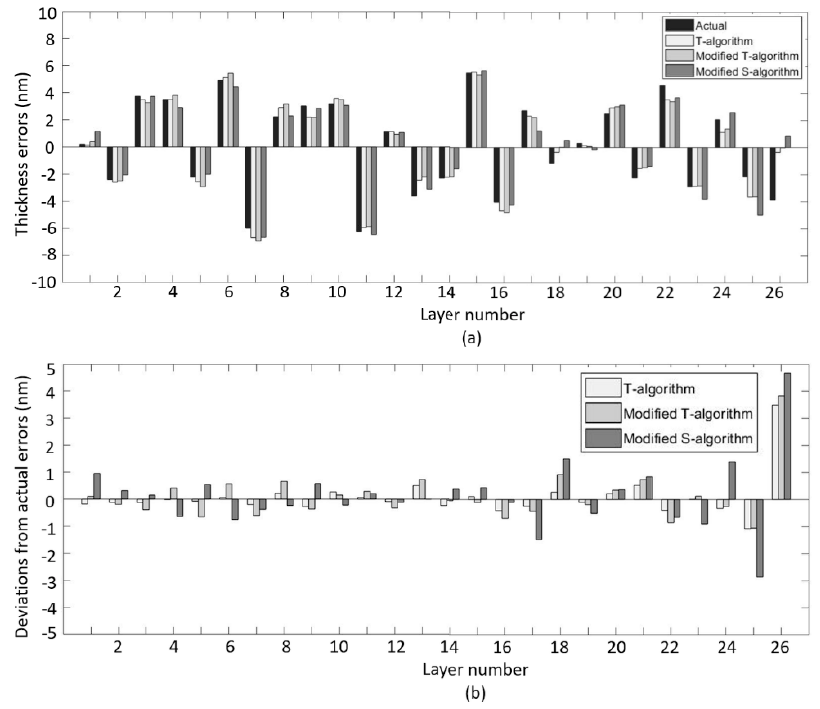
Figure 3. Comparison of the average values of thickness errors found by all three algorithms with actually made thickness errors ( a ) and differences between these values and actual errors ( b ).